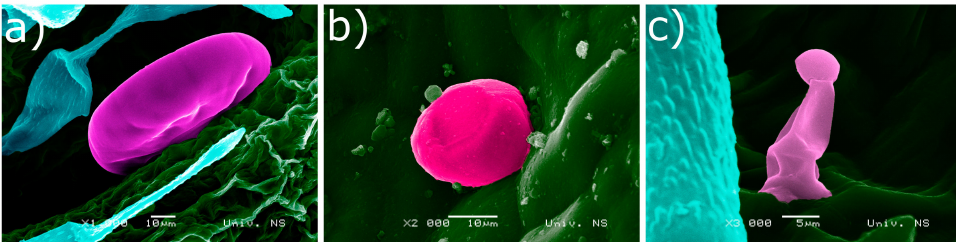
Figure 2. Scanning electron micrographs of glandular trichomes found in analyzed taxa. ( a ) Peltate glandular trichome; ( b ) type 1 capitate glandular trichome (C1); ( c ) type 2 capitate glandular trichome (C2); SEM micrographs colored using Portable Photoshop CS6.